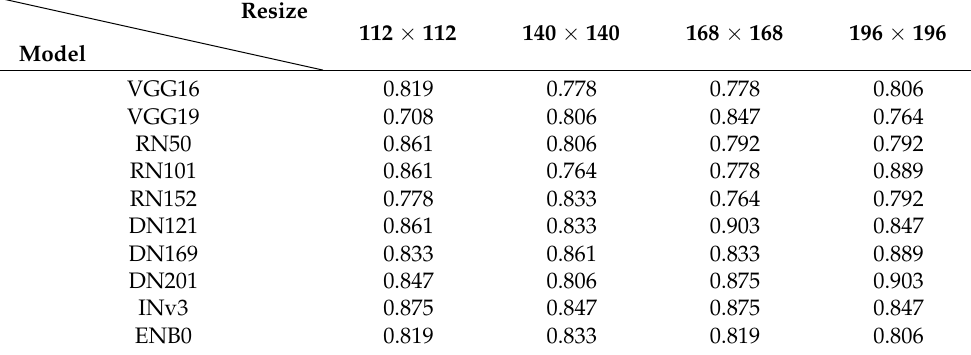
Table 7. Accuracies of compared CNNs for different image